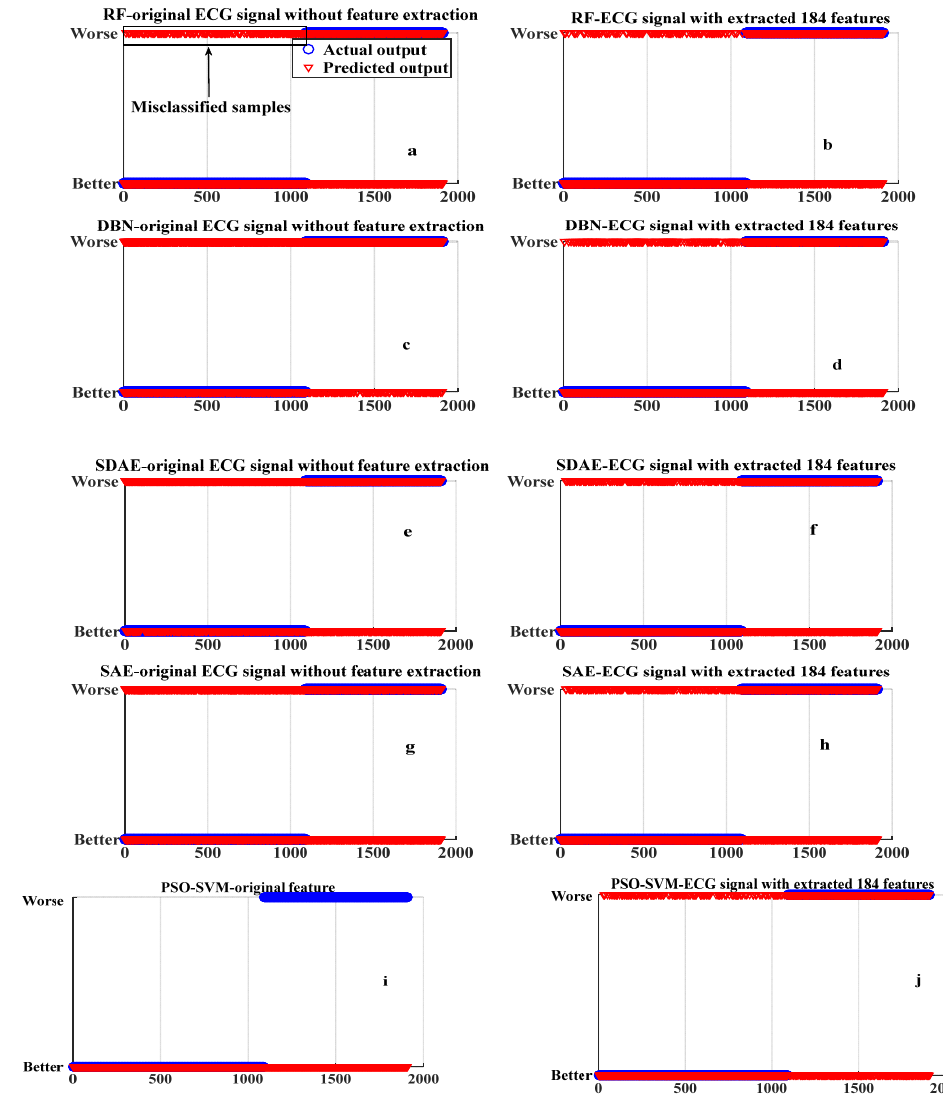
Figure 6. The wellness prediction result of different models. Table 5. The performance comparison of different models.